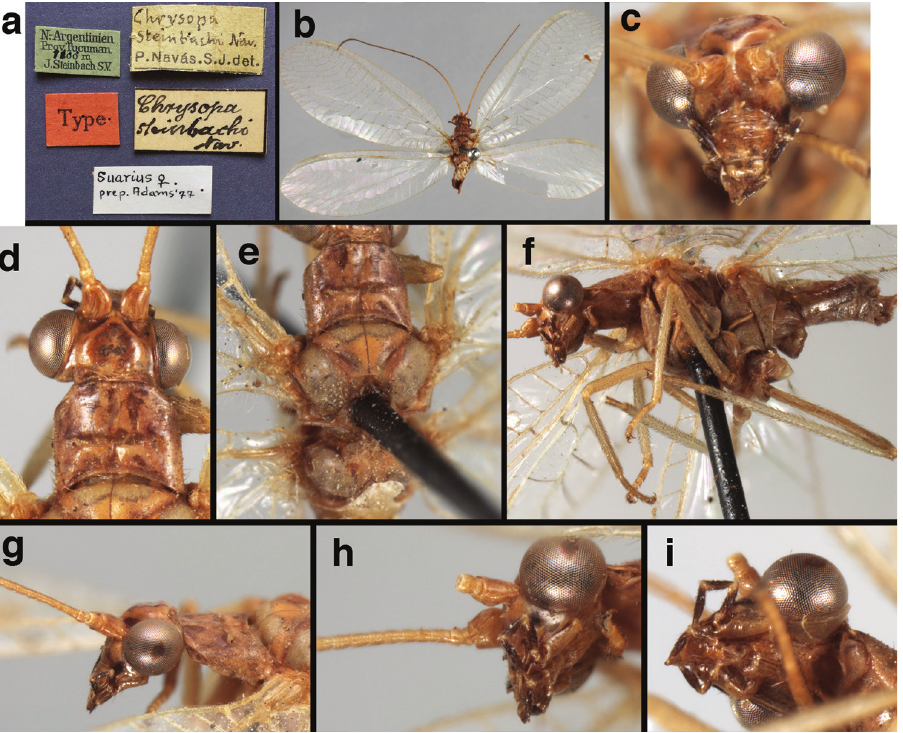
Figure 137. Chrysopa steinbachi Navás: External features, ( a ) labels ( b ) habitus, dorsal ( c ) head, frontal ( d ) head, prothorax, dorsal ( e ) thorax, dorsal ( f ) head, thorax, ventrolateral ( g ) head, prothorax, lateral ( h ) head, ventrolateral ( i ) head, ventral (Argentina, Tucumán, holotype, female,